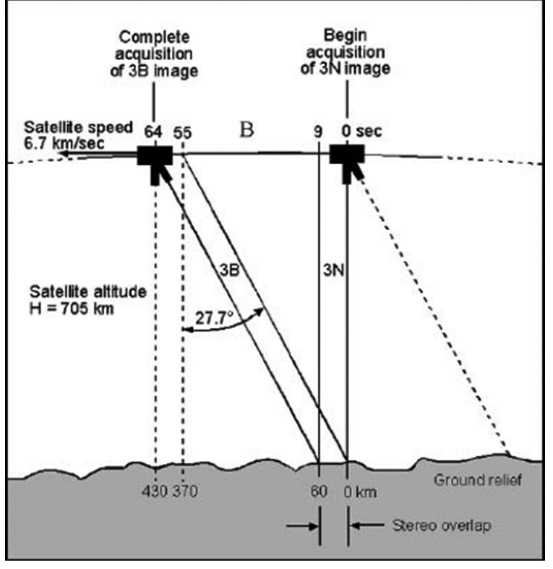
Fig. 2 – ASTER stereo configuration (source: Toutin